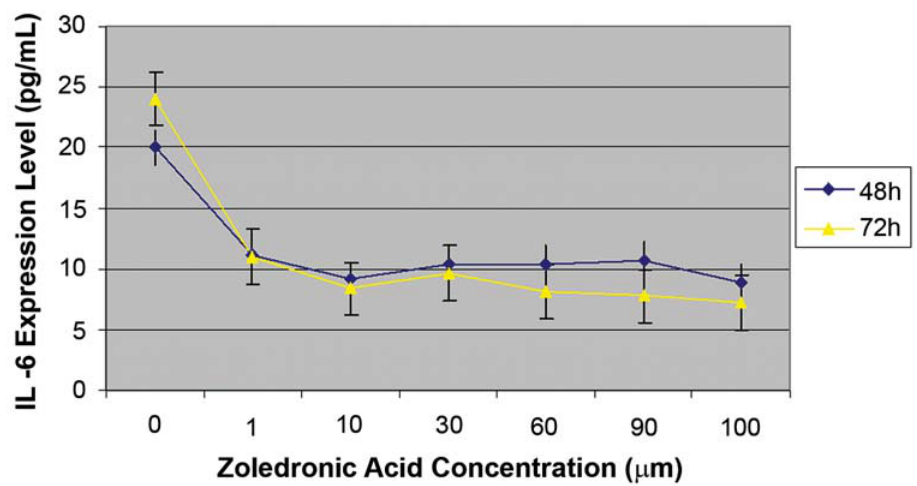
Figure 3 – (cid:3)(cid:40)(cid:73)(cid:73)(cid:72)(cid:70)(cid:87)(cid:3)(cid:82)(cid:73)(cid:3)(cid:93)(cid:82)(cid:79)(cid:72)(cid:71)(cid:85)(cid:82)(cid:81)(cid:76)(cid:70)(cid:3)(cid:68)(cid:70)(cid:76)(cid:71)(cid:3)(cid:87)(cid:85)(cid:72)(cid:68)(cid:87)(cid:80)(cid:72)(cid:81)(cid:87)(cid:3)(cid:82)(cid:81)(cid:3)(cid:44)(cid:47)(cid:16)(cid:25)(cid:3)(cid:86)(cid:72)(cid:70)(cid:85)(cid:72)(cid:87)(cid:76)(cid:82)(cid:81)(cid:3)(cid:76)(cid:81)(cid:3)(cid:51)(cid:38)(cid:16)(cid:22)(cid:3)(cid:70)(cid:72)(cid:79)(cid:79)(cid:3)(cid:79)(cid:76)(cid:81)(cid:72)(cid:17)(cid:3)(cid:20)(cid:19) (cid:24) viable cell/well was treated with increasing con- centrations of zoledronic acid. IL-6 levels were measured after 48 and 72 hours by ELISA in the supernatants of zoledronic acid treated (cid:70)(cid:72)(cid:79)(cid:79)(cid:86)(cid:17)(cid:3)(cid:51)(cid:82)(cid:76)(cid:81)(cid:87)(cid:86)(cid:15)(cid:3)(cid:87)(cid:75)(cid:72)(cid:3)(cid:80)(cid:72)(cid:68)(cid:81)(cid:3)(cid:82)(cid:73)(cid:3)(cid:68)(cid:87)(cid:3)(cid:79)(cid:72)(cid:68)(cid:86)(cid:87)(cid:3)(cid:87)(cid:75)(cid:85)(cid:72)(cid:72)(cid:3)(cid:76)(cid:81)(cid:71)(cid:72)(cid:83)(cid:72)(cid:81)(cid:71)(cid:72)(cid:81)(cid:87)(cid:3)(cid:72)(cid:91)(cid:83)(cid:72)(cid:85)(cid:76)(cid:80)(cid:72)(cid:81)(cid:87)(cid:86)(cid:30)(cid:3)(cid:69)(cid:68)(cid:85)(cid:86)(cid:15)(cid:3)(cid:54)(cid:39)(cid:17)(cid:3)(cid:19)(cid:15)(cid:3)(cid:88)(cid:81)(cid:87)(cid:85)(cid:72)(cid:68)(cid:87)(cid:72)(cid:71)(cid:3)(cid:70)(cid:82)(cid:81)(cid:87)(cid:85)(cid:82)(cid:79)(cid:86)(cid:17)(cid:3)(cid:51)(cid:3)(cid:31)(cid:3)(cid:19)(cid:17)(cid:19)(cid:24)(cid:15)(cid:3)(cid:89)(cid:86)(cid:17)(cid:3)(cid:70)(cid:82)(cid:81)(cid:87)(cid:85)(cid:82)(cid:79)(cid:86)(cid:17)